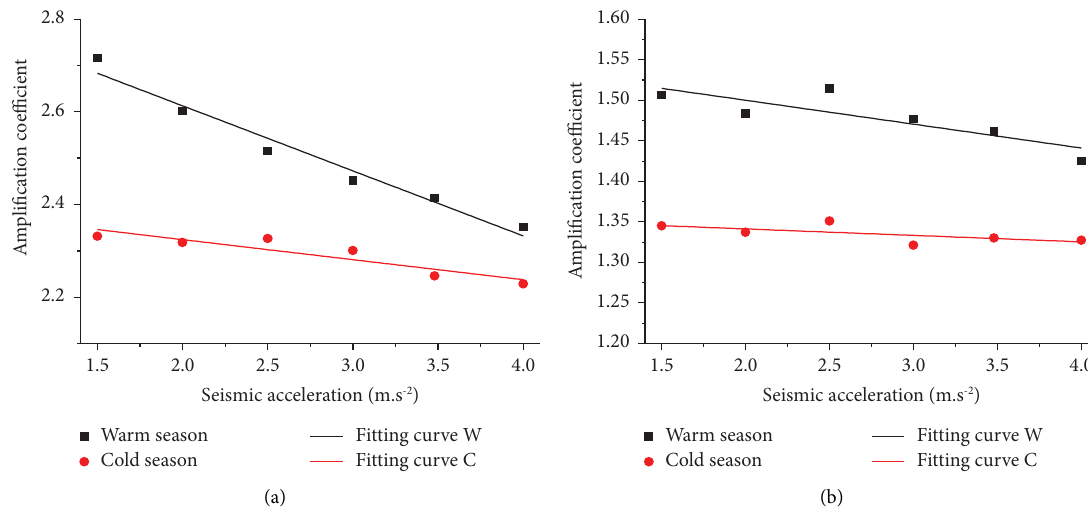
Figure 7: Te variation of amplifcation coefcient with the input ground motion acceleration amplitude: (a) characteristic point S ; (b) characteristic point T